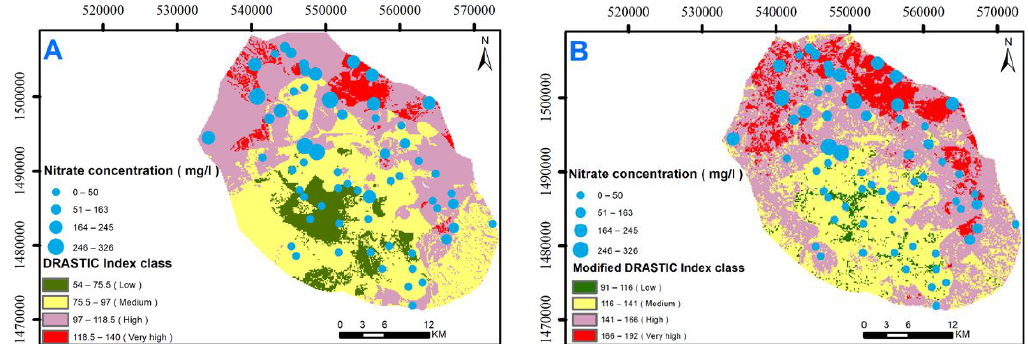
Figure 7. The distribution of the concentration of nitrates in groundwater are shown on the conven- tional DRASTIC index map ( A ) and the modified DRASTIC index map ( B ). A scatter plot of both indices was plotted against the nitrate concentration (Figure 8). Statistically, using Pearson’s correlation coefficient (r), both the DRASTIC and modified DRASTIC index values showed positive and moderate correlations with the nitrate con- centrations, of 0.681 and 0.702, respectively. Moreover, the modified DRASTIC model, which includes lineament and land use layers, was slightly better correlated (r = 0.702) than the conventional DRASTIC model. Therefore, the validation analysis revealed that the modified DRASTIC method accounted for nearly 50% (r = 0.702) of the relationship in the variation of the index values and nitrate concentrations in the groundwaters of the study area.